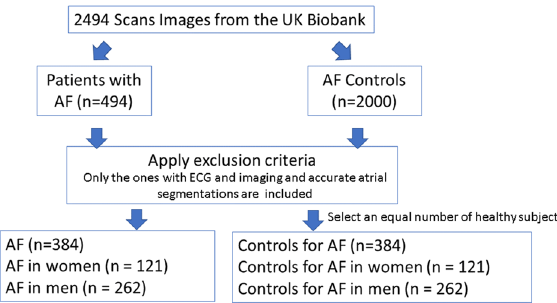
Figure 4. The process to select the data from the UK